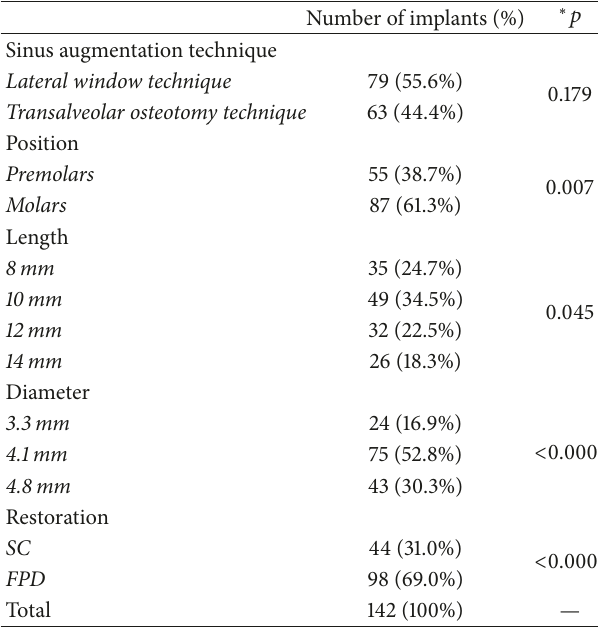
Table 2: Implant